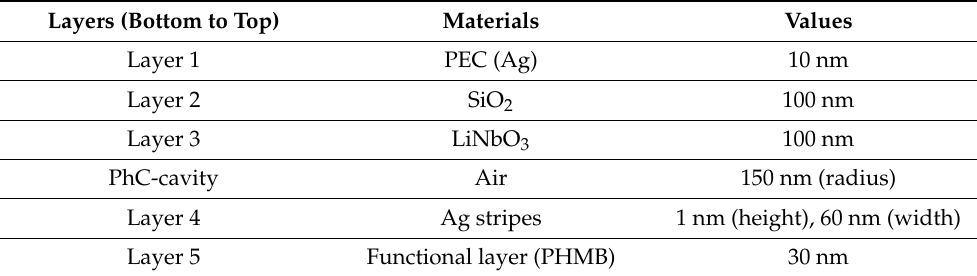
Table 1. Optimized structural values of the CO 2 sensor. Layers (Bottom to